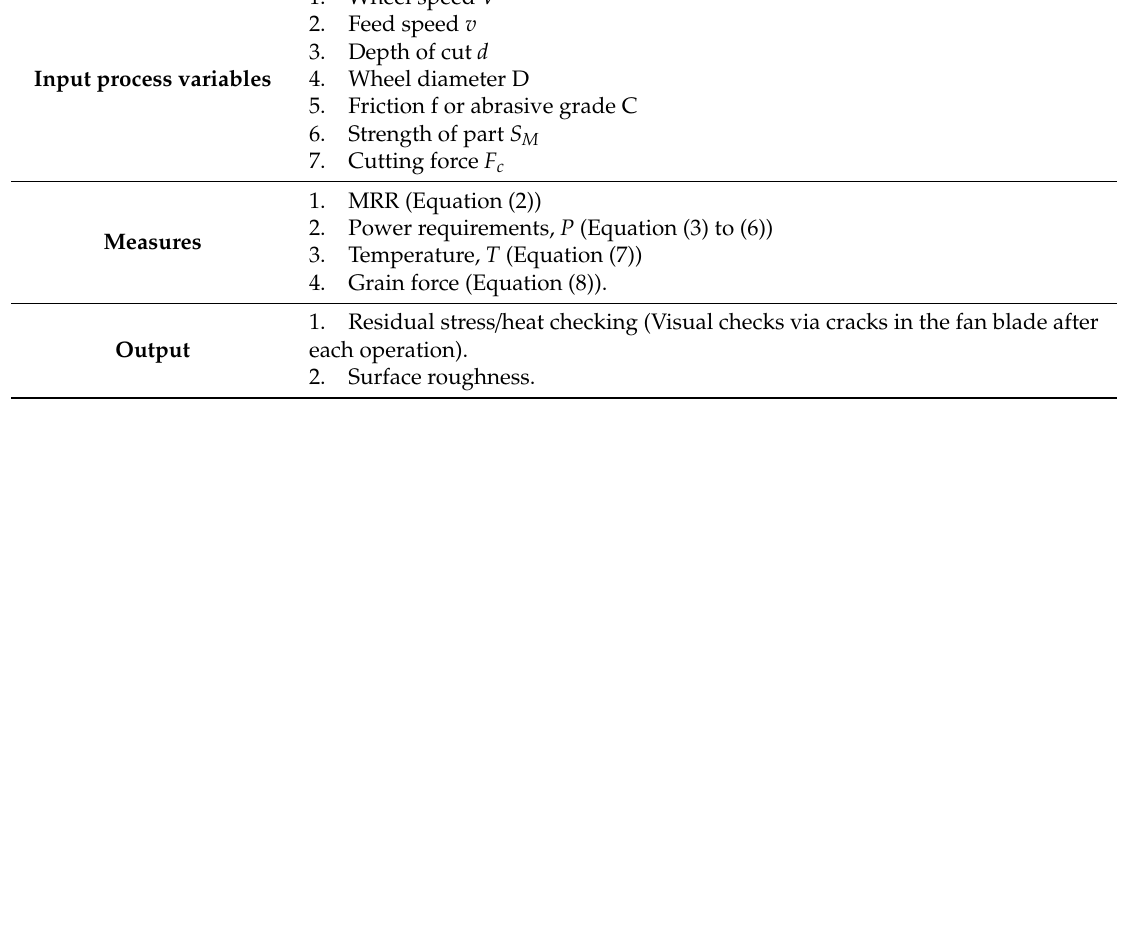
Table 1. A table showing the input process parameters, process measures, and output parameters.